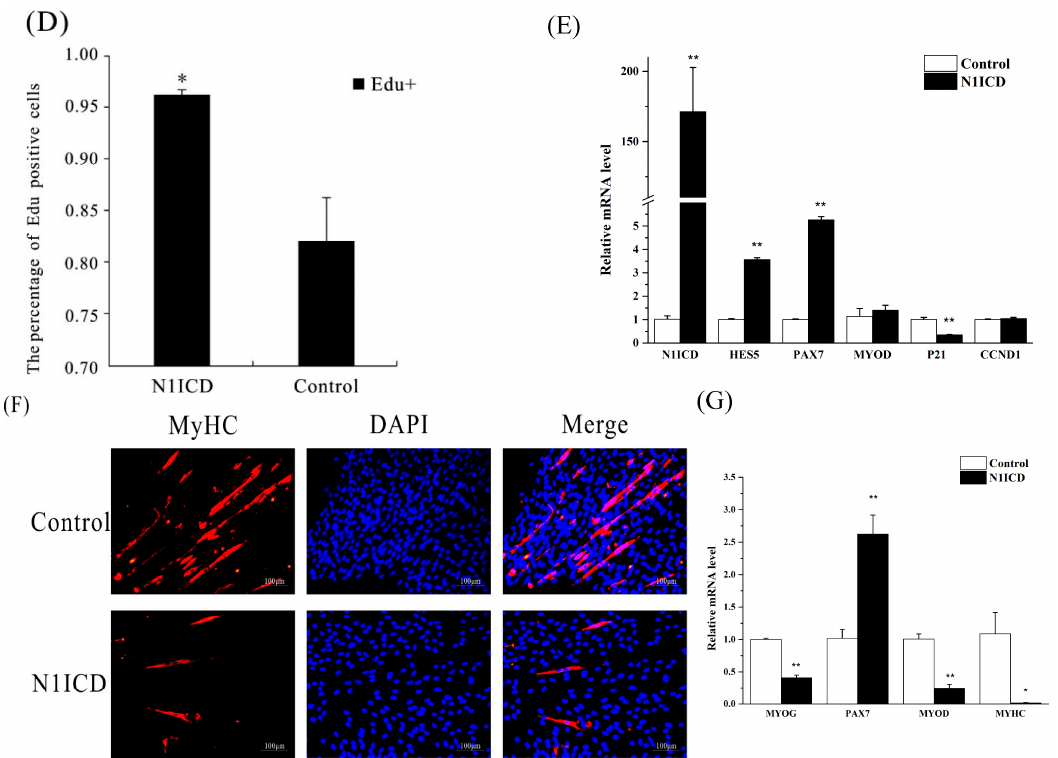
Figure 1. The model of N1ICD overexpressed PSCs. ( A ) The expression of N1ICD was tested by immunocytochemistry. DAPI, blue, represents nuclei; NOTCH1, red; Merge, pink, represents N1ICD expressed in nuclei of PSCs. ( B ) One week later, the degree of green fluorescence protein (GFP) in the control group is greener than the N1ICD-overexpressed group. However, the level of N1ICD expression in the N1ICD-overexpressed group is more than the control group. ( C , D ) Representative images of the immunofluorescent staining for proliferating PSCs are shown. Proliferating PSCs were labeled with Edu fluorescent dye (red). ( E ) Q-RT-PCR showed the changes of N1ICD, hes family bHLH transcription factor 5 (HES5), paired box 7 (PAX7), myogenic differentiation 1 (MYOD), cyclin dependent kinase inhibitor 1A (P21) and cyclin D1 (CCND1) in proliferating PSCs. Overexpressed N1ICD in PSCs did not show any changes in mRNA level of MYOD and CCND1. * p < 0.05; ** p < 0.01. Data are the mean ± S.E.M, n = 3 for each treatment. ( F ) Representative images of the immunofluorescent staining for differentiating PSCs are shown. Myosin heavy chain (MYHC) was labeled by fluorescent dye (red). Scale bar = 20 μ m (×200 magnification). ( G ) Q-RT-PCR showed the changes of myogenin (MYOG), PAX7, MYOD and MYHC in overexpressed N1ICD differentiating PSCs. MYOG and MYOD significantly decreased while PAX7 significantly increased in overexpressed N1ICD differentiating PSCs. * p < 0.05; ** p < 0.01. Data are the mean ± S.E.M, n = 3 for each treatment.